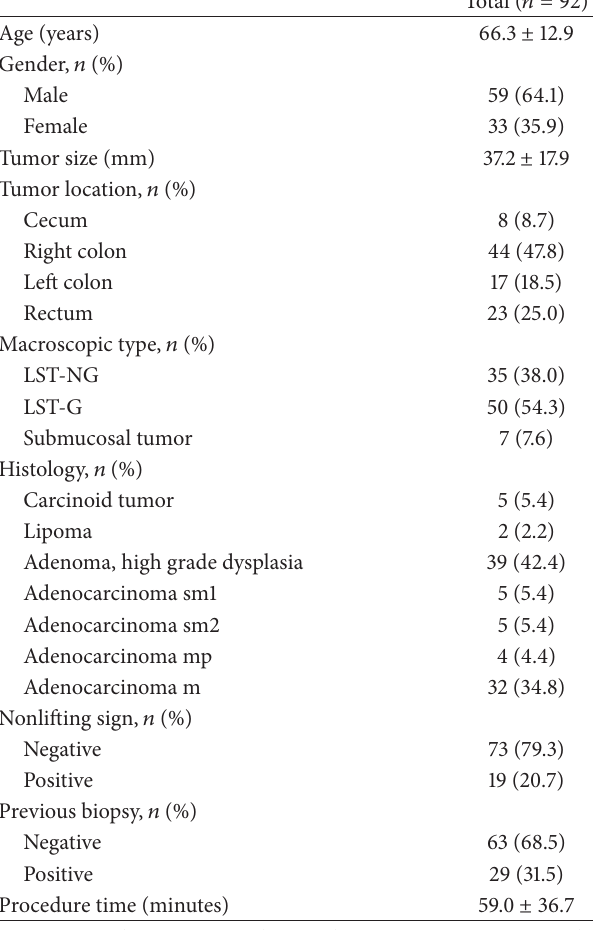
Table 1: Patient characteristics ( 𝑛 = 92